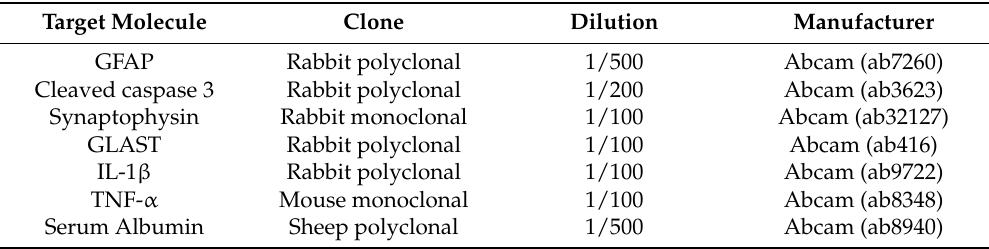
Table 1. Targets, dilution, and sources of applied primary antibodies (Abcam, Cambridge, UK) in